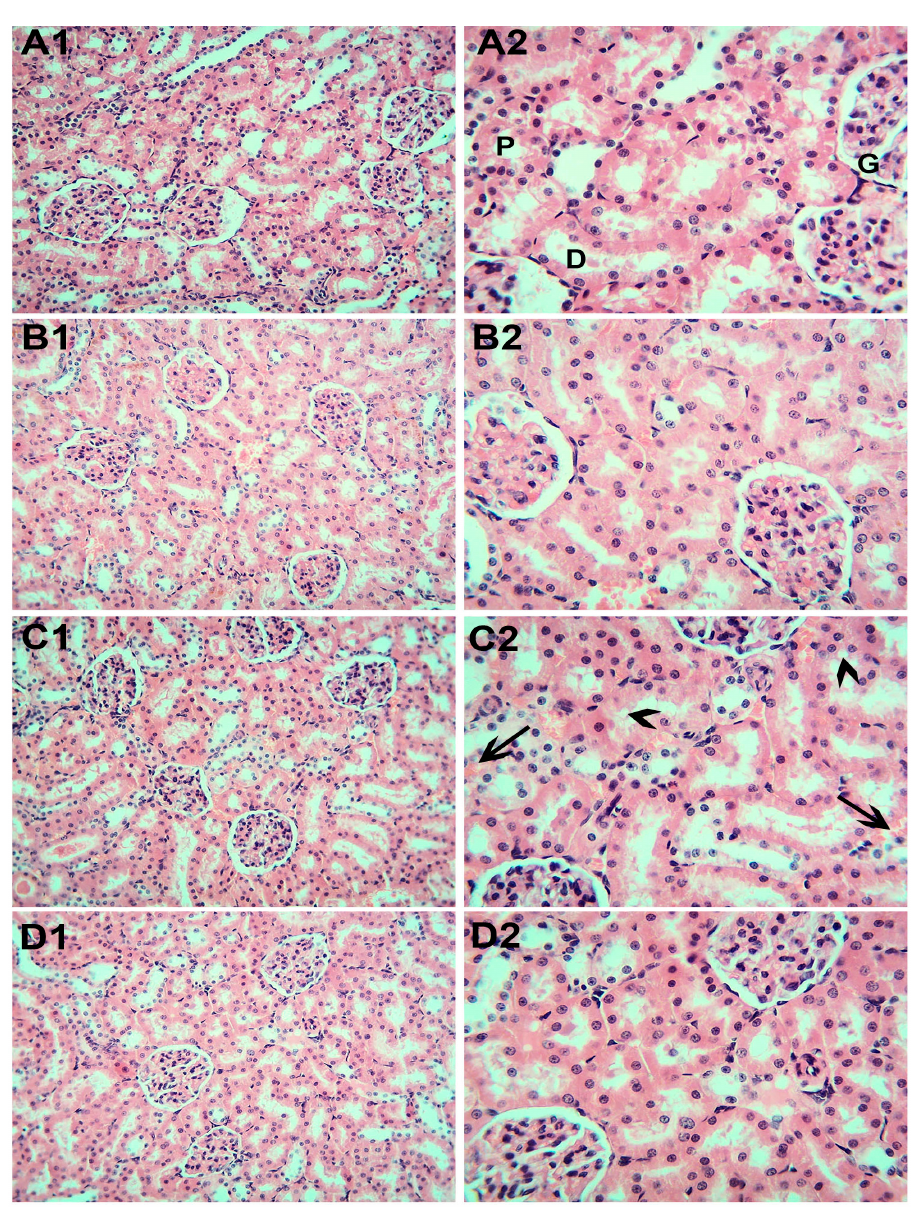
Figure 3. Representative kidney section photomicrographs. ( A1 , A2 ) Control rats demonstrating the normal structure of the glomeruli (G), proximal (P), and distal (D) convoluted tubules. ( B1 , B2 ) Rata that received Mg. ( C1 , C2 ) Rats exposed to SiNPs showing inter-tubular congestion (arrows) with swelling and vacuolation of the endothelial lining of the proximal and distal convoluted tubules (arrow heads). ( D1 , D2 ) Rats exposed to SiNPs and that received Mg showing normal cellularity of the glomerulus and renal tubules. H&E. ( A1 , B1 , C1 , D1 ) ×20 magni fi cation. ( A2 , B2 , C2 , D2 ) ×40 magni fi cation.